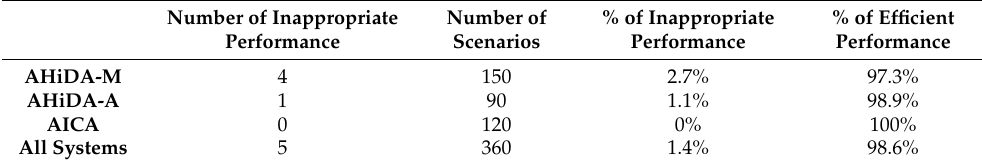
Table 1. Evaluation of the HMT manager